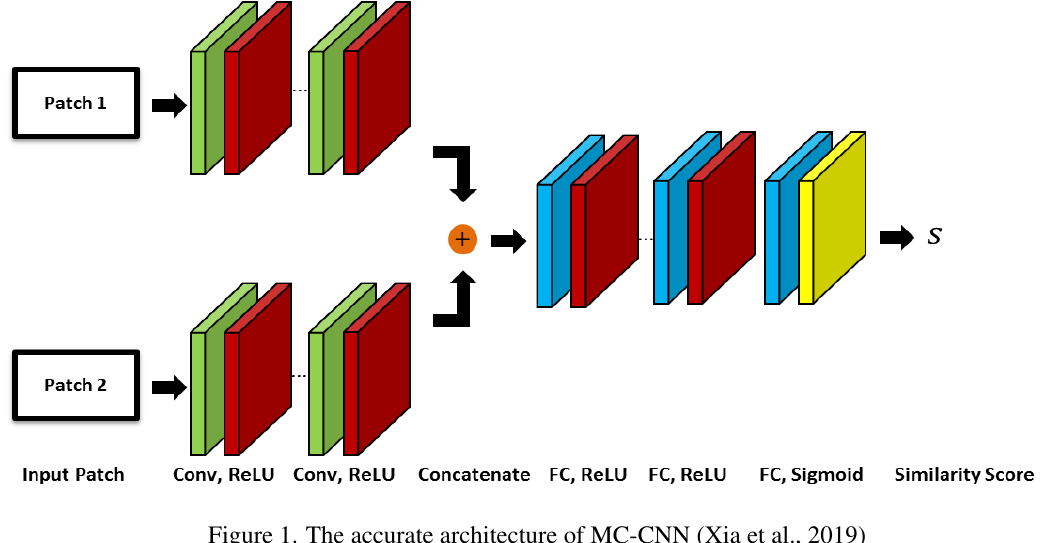
Figure 1. The accurate architecture of MC-CNN (Xia et al., 2019)